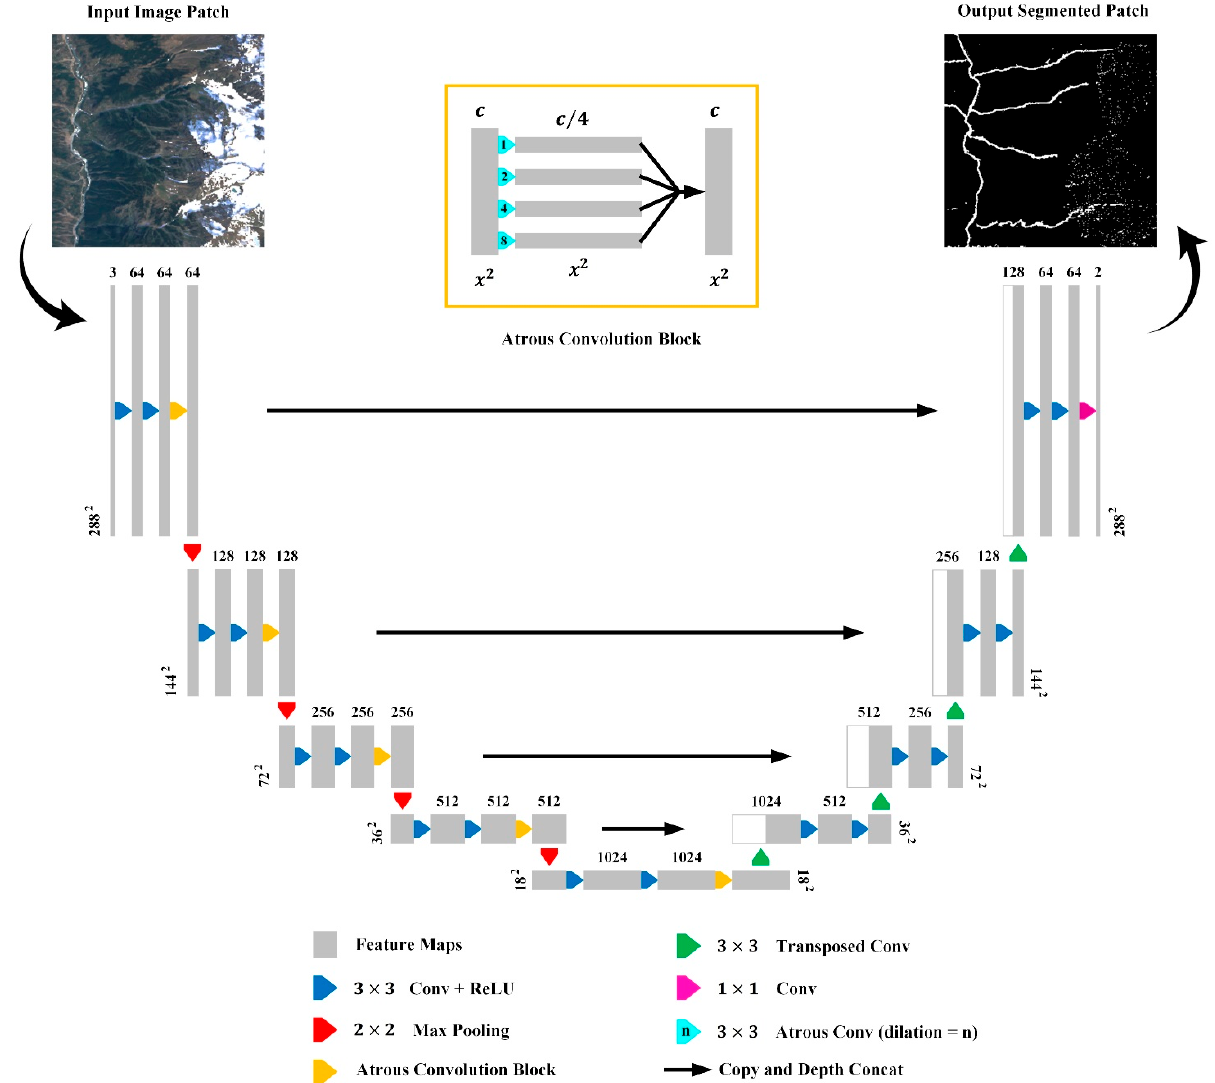
Figure 5. Depth-wise network architecture of the proposed AUnet model.